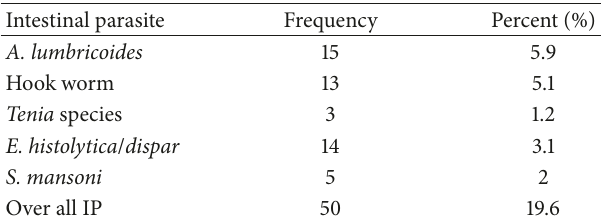
Table2:Prevalenceofintestinalparasitesamong256PTBsuspected patients at University of Gondar Hospital, Ethiopia, 2017.